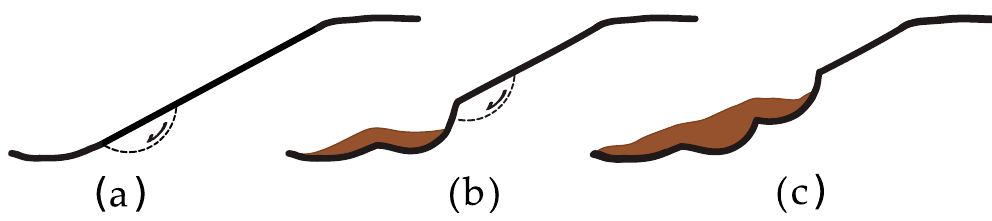
Table 1. Definition of quick clay in three